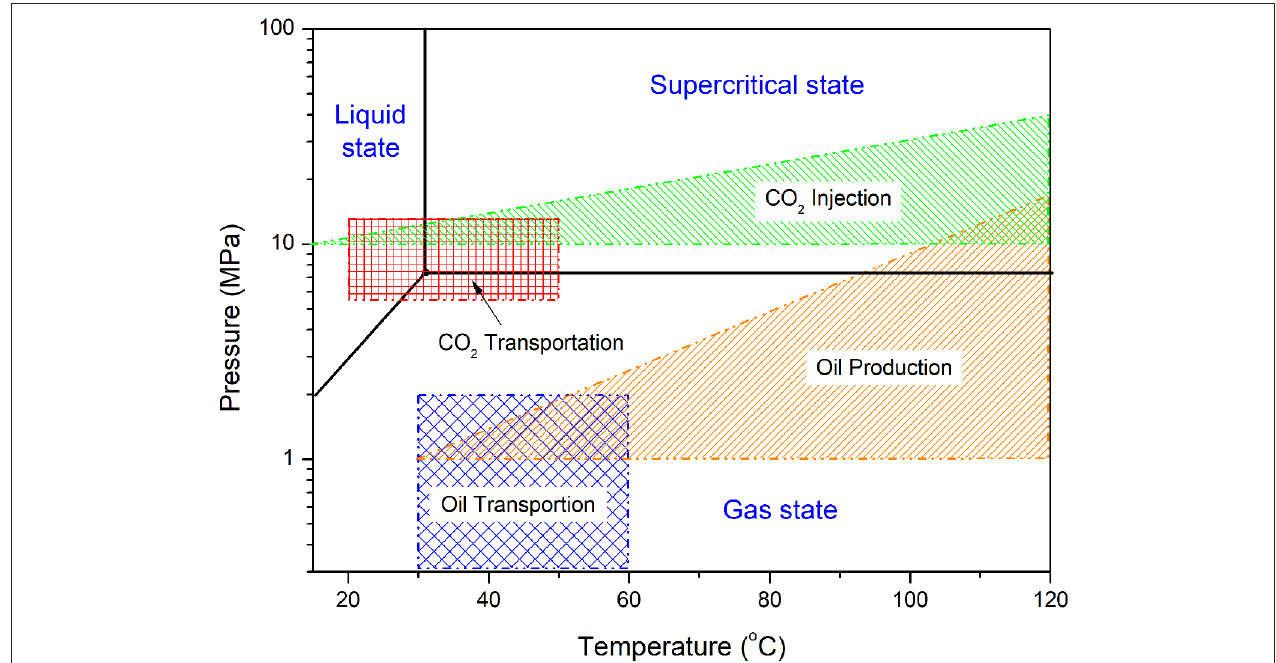
FIGURE 2 | Pressure and temperature diagram in the whole chain process of a CO 2 -EOR